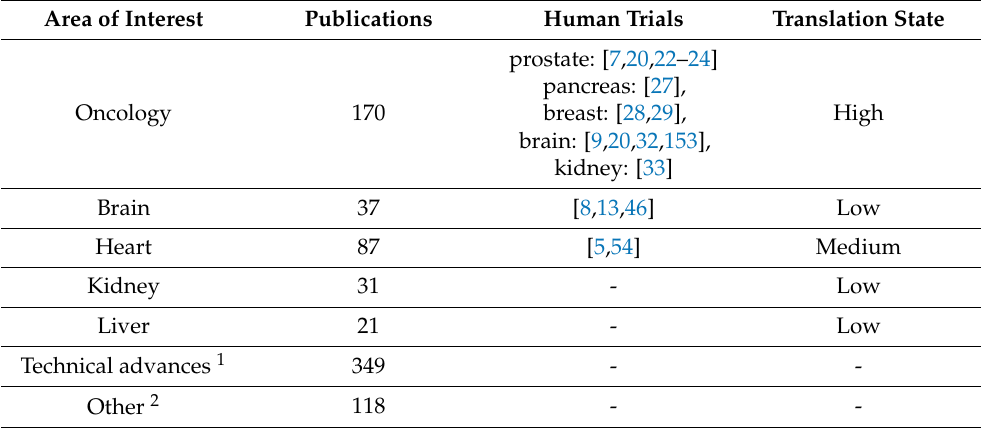
Table 1. Overview of applications for which clinical trials have been performed with hyperpolarized carbon-13 MRI and their translation state towards clinical adaption.